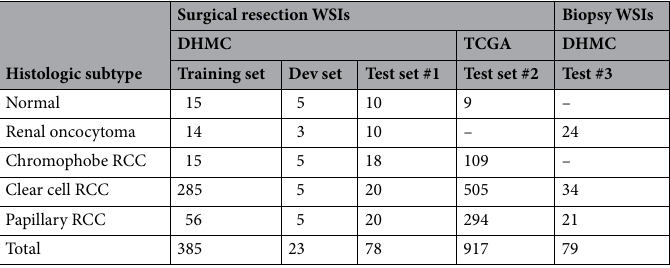
Table 4. Distribution of the collected whole-slide images among renal cell carcinoma and benign subtypes. “–” indicates the corresponding subtype was not available in the dataset.